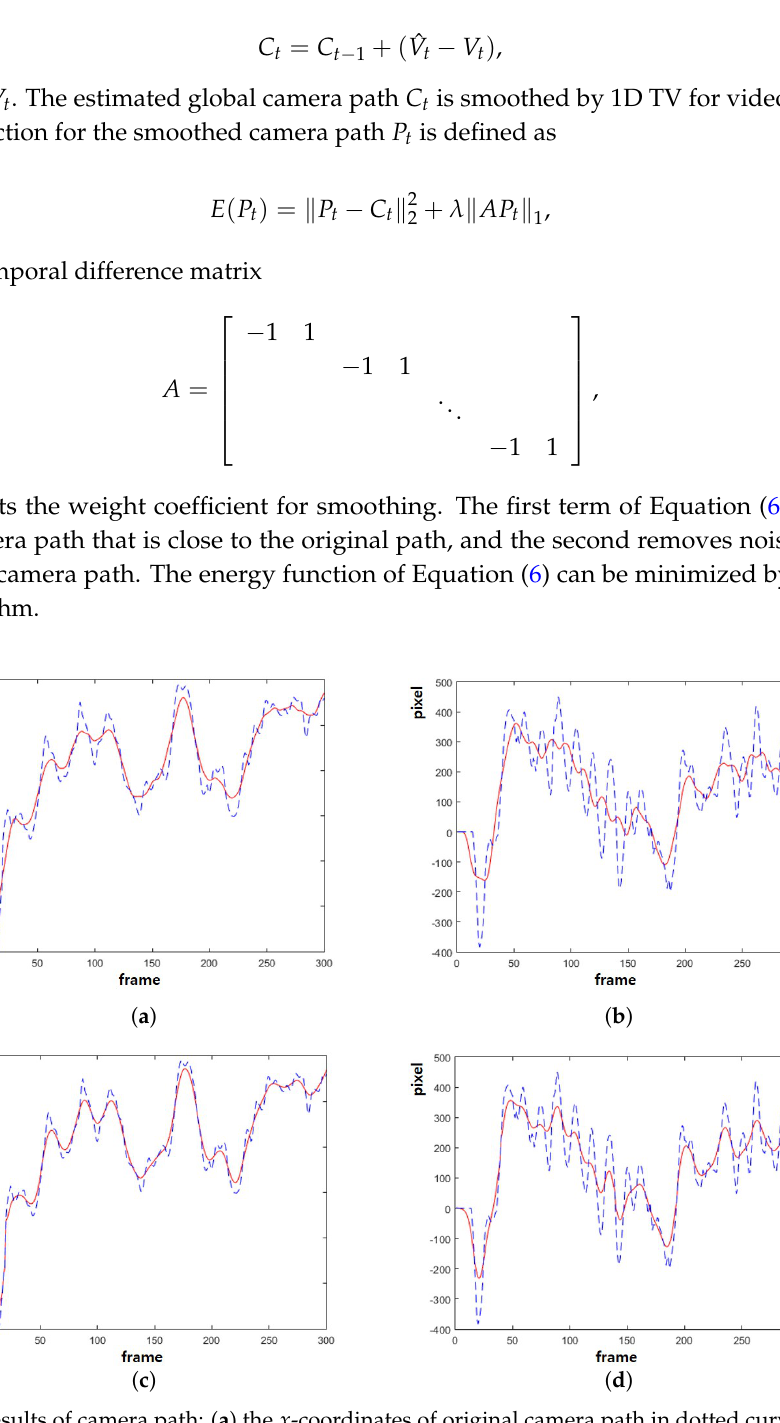
Figure 5. Results of camera path: ( a ) the x -coordinates of original camera path in dotted curve and the smoothed camera path using the moving average filter in solid curve, ( b ) the y -coordinates of original camera path in dotted curve and the smoothed camera path using the moving average filter in solid curve, ( c ) the x -coordinates of original camera path in dotted curve and the smoothed camera path using the proposed method in solid curve and ( d ) the y -coordinates of original camera path in dotted curve and the smoothed camera path using the proposed method in solid